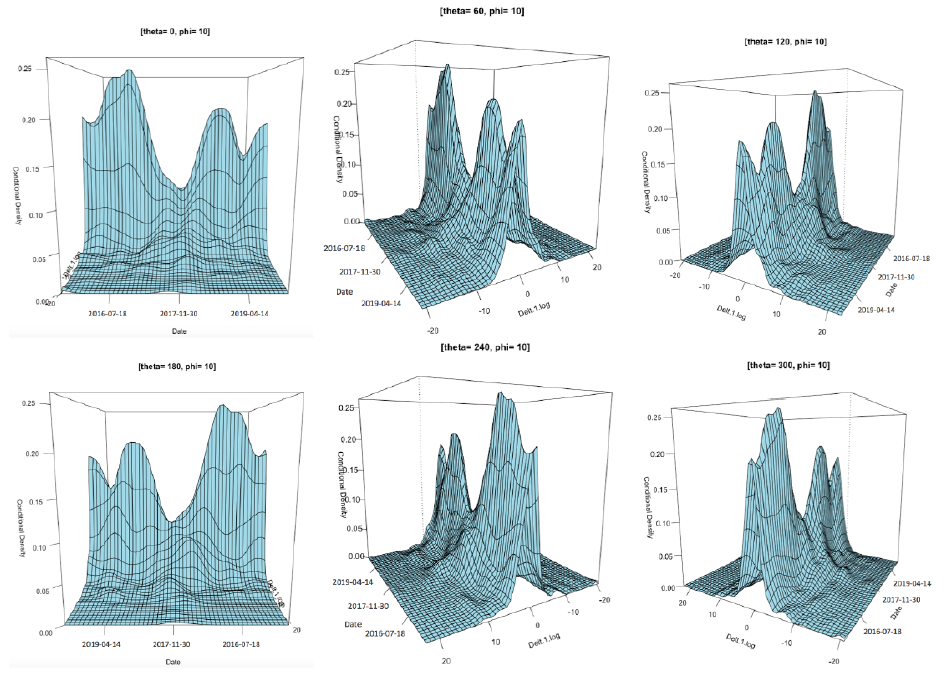
Figure 3. Density of Bitcoin: pre-COVID.